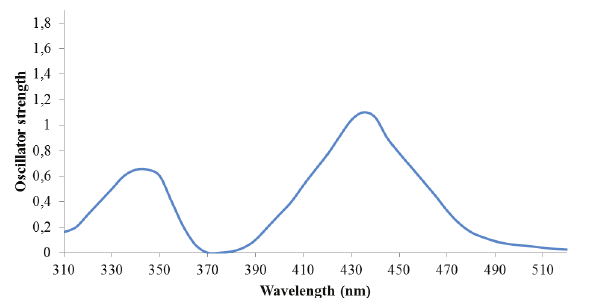
Figure 5: The UV-Visible spectrum of system 1 measured shown in Figure 5 matches with that of the simulated dye. It shows that peak of experimental pattern is slightly red-shift ed as compared to that of simulated pattern. This occurs due to strains present in structure, solvent eff ect or instrumental error.